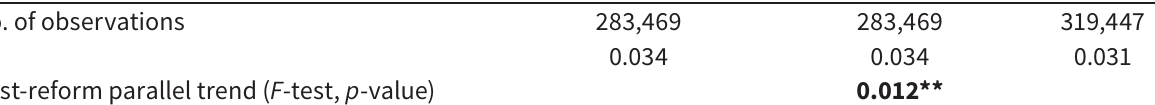
DiD: short-term vs. long-term unemployed, among jobseekers aged 45–48 years